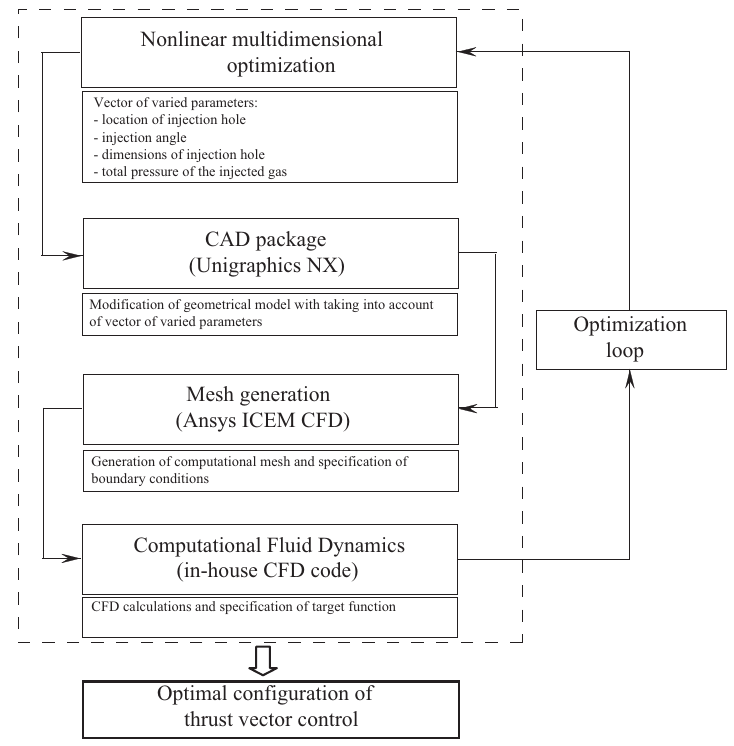
Figure 2. Optimization of thrust vector control with CFD.